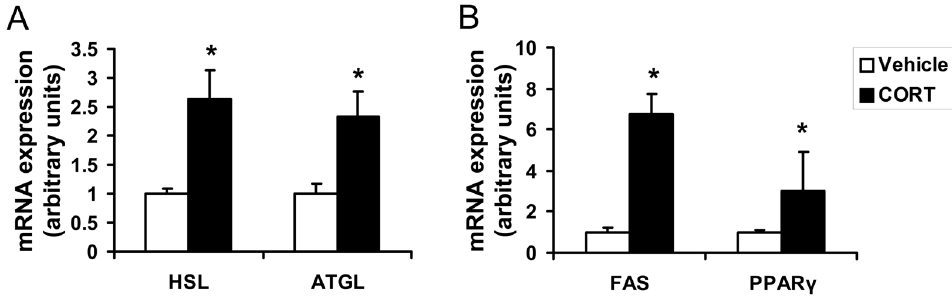
Figure 3. Effect of CORT on expressions of lipolytic and lipogenic genes in epididymal WAT of mice. ( A ) Relative expression of lipolysis- related genes, and ( B ) lipogenesis-related genes in epididymal white adipose tissue (WAT) of mice treated with 100 m g/ml CORT or vehicle for 4 weeks. Data are expressed as group means 6 SEM (n=6 by group). All the mRNA expression data are normalized to the house keeping gene (18S rRNA). * P , 0.05 compared with vehicle.